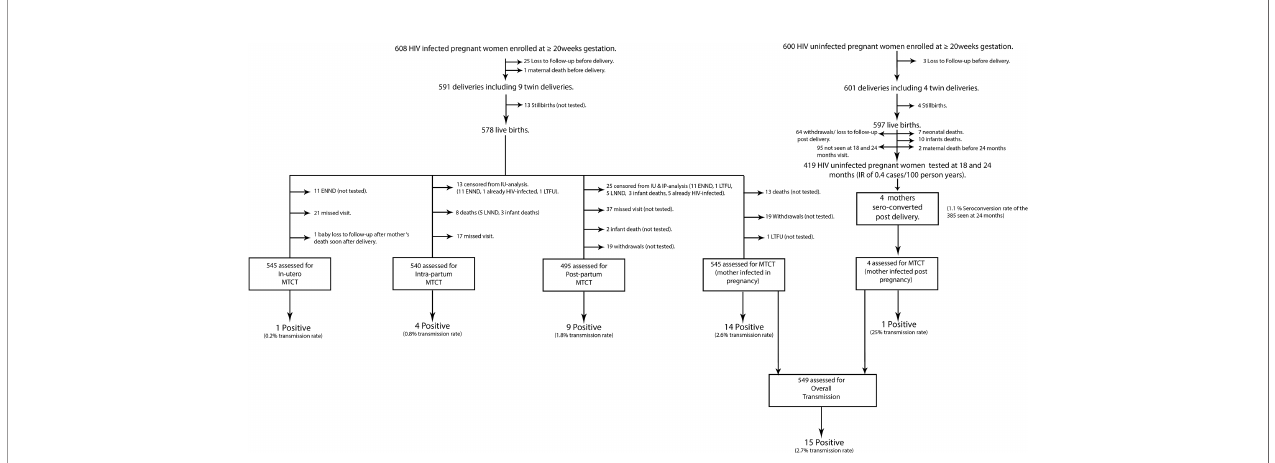
FIGURE 1 | Flow chart showing analysis steps to determine rates of mother-to-child transmission of HIV in women infected in pregnancy and those seroconverting postnatally. HIV, human immunode fi ciency virus; ENND, early neonatal deaths (death of a newborn occurring within 7 days after birth); LNND, late neonatal deaths (death of a live born infant within 28 days of life); infant death, death of an infant occurring after 28 days of life; IU-analysis, in-utero analysis; IP-analysis, intra-partum analysis; MTCT, mother-to-child-transmission; LTFU, lost to